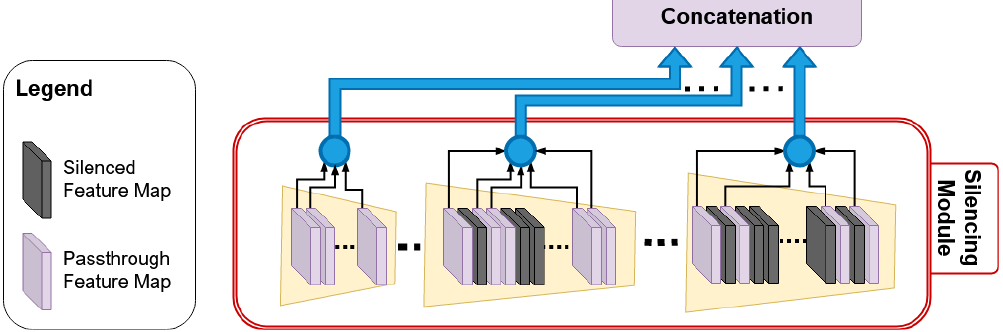
Figure 6. An example of a feature space of different crack images (rows) during an encoding operation. Some feature responses are strongly indicative of crack presence ( a – c , f , h ), while weak feature responses ( d , e , g ) generate a weight matrix close to zero. The weak feature maps are eliminated using Equation (1).